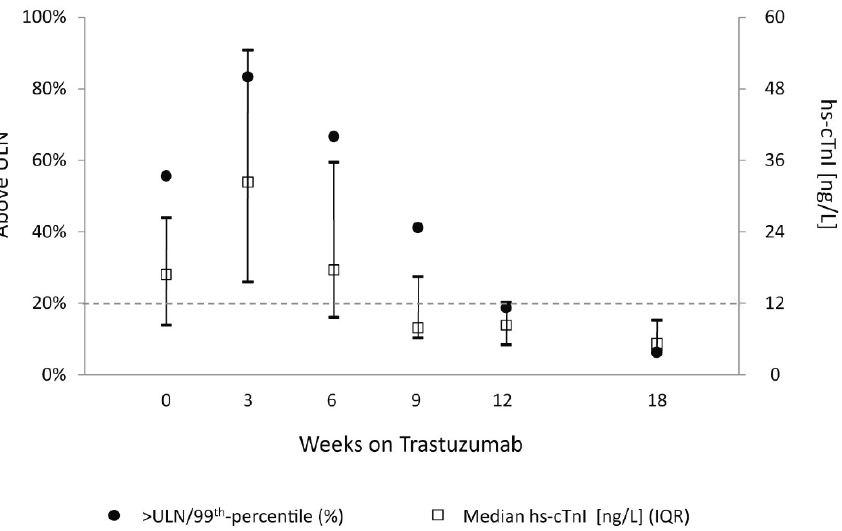
Figure 6. Troponin behavior during trastuzumab therapy following previous chemotherapy with other drugs including anthracyclines [45].